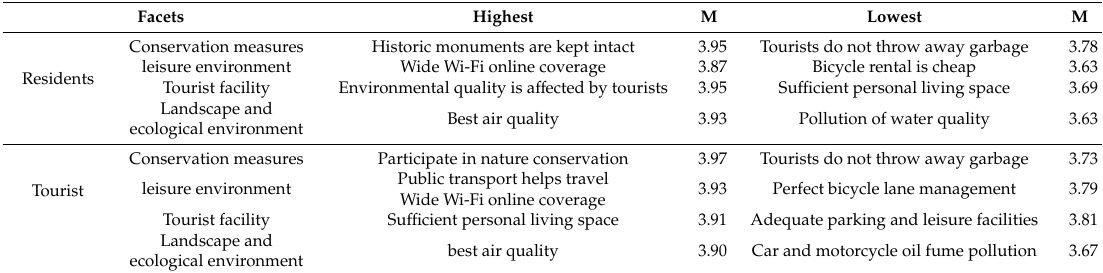
Table 9. Perception of the current state of environmental development by residents and visitors. Facets Highest M Lowest